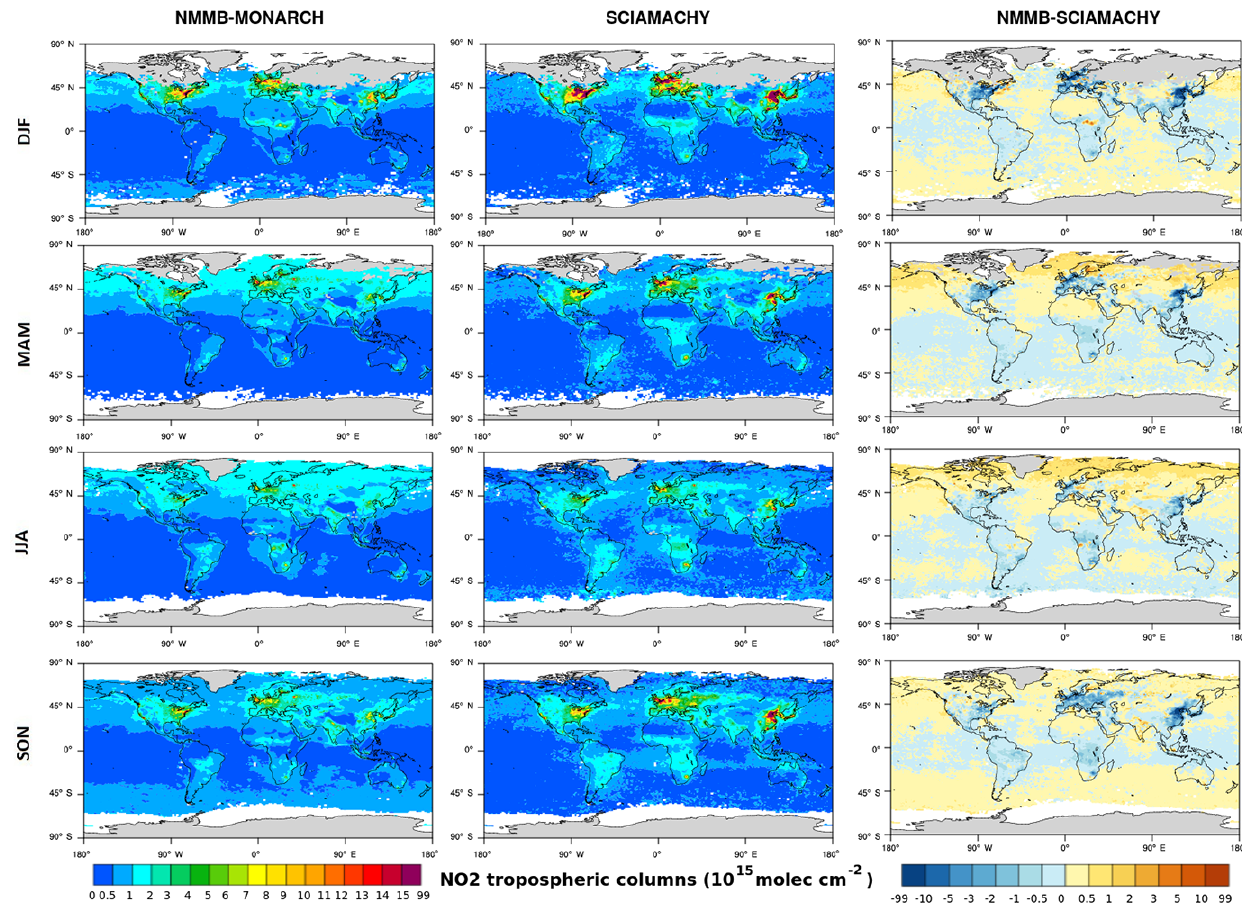
Figure 10. Comparison of modeled NMMB-MONARCH NO 2 vertical tropospheric columns against satellite data (SCIAMACHY) in 10 15 moleccm − 2 . From top to bottom: DJF, MAM, JJA, and SON for year 2004. NMMB-MONARCH data are displayed in the left panel, SCIAMACHY data in the middle panel and the bias in the right